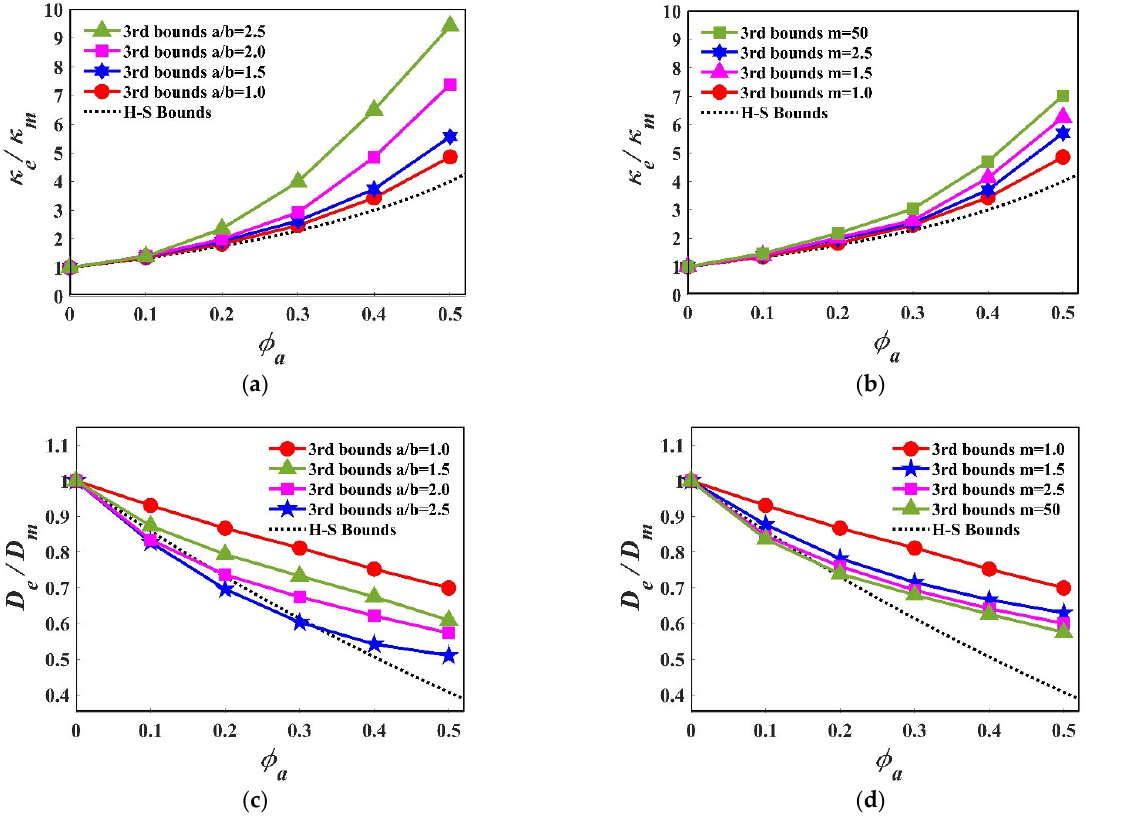
Figure 7. Third ‐ order approximation of effective properties with strong contrast: ( a ) Normalized thermal conductivity with different aspect ratio; ( b ) Normalized thermal conductivity with different deformation coefficient; ( c ) Normalized diffusion coefficient with different aspect ratio; ( d ) Normalized diffusion coefficient with different deformation coefficient.